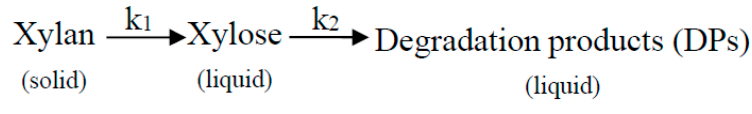
Scheme 1. The reaction process of xylan involved in the Saeman model.